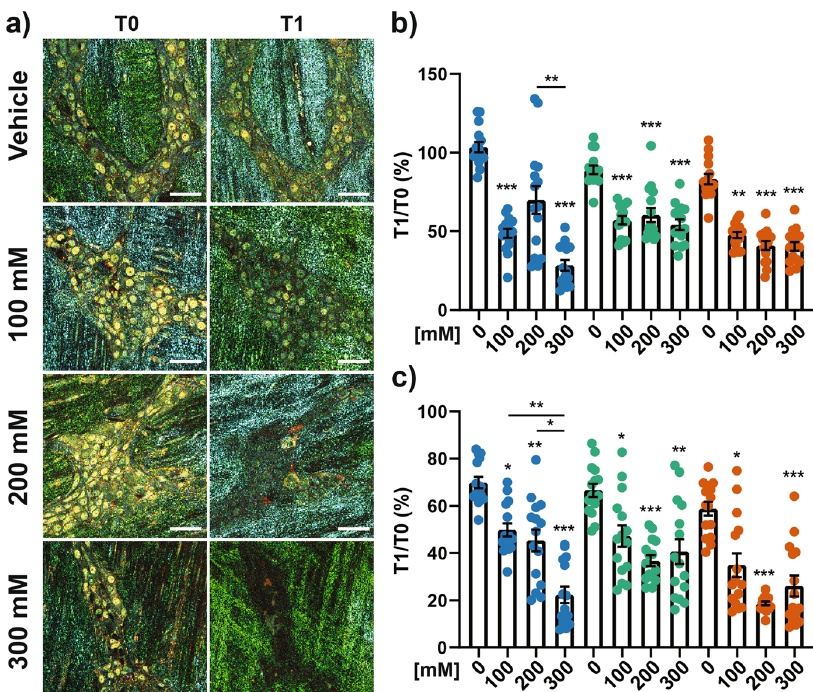
Fig. 6 Dose – response effect of mannitol on D-FFOCT signal. a D-FFOCT micrograph of the same ganglia before (T0) and after a 30 min treatment with vehicle (Krebs), 100, 200, or 300 mM of mannitol (T1). Scale bar: 25 µ m. b , c Ratio T1:T0 in percentage of the mean intensity for low (blue), medium (bluish green), or high (vermillion) range of frequency for a treatment with vehicle (Krebs, 0) or 100, 200, 300 mM of mannitol. Mean intensity was calculated from the whole ganglia ( b ) or from the nuclear structure ( c ). n = 15 ganglia from 3 mice. Mean value + / − SEM; Statistic: for each color, two- tailed Kruskal – Wallis test followed by a Dunn ’ s. * p < 0.05; ** p < 0.01, *** p < FFOCT and D-FFOCT imaging . FFOCT and D-FFOCT images were performed using the Light-CT scanner (LLtech, Paris, Fr) placed on an anti-vibratory table (CleanBench with Gimbal Piston vibration isolation, Photon Lines SAS, St Ger- main-en-Laye, Fr). The Sylgard carrier plate was placed in the scanner holder with